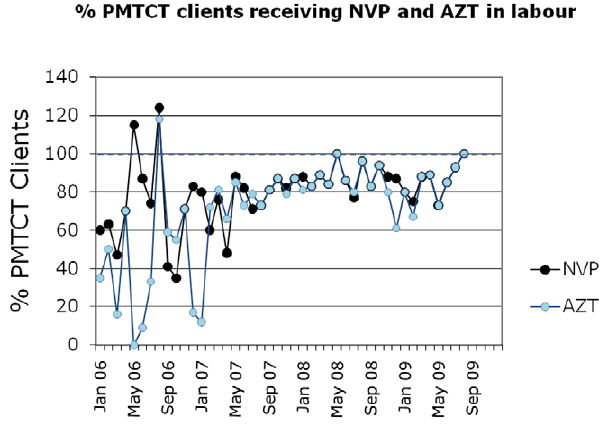
Figure 2. Percentage of HIV positive women receiving intra- partum administration of NVP and AZT. Legend: The quality of the data, and the reliability and variation of care in the administration of PMTCT in labour improved after the QI approach was introduced to the labour ward.